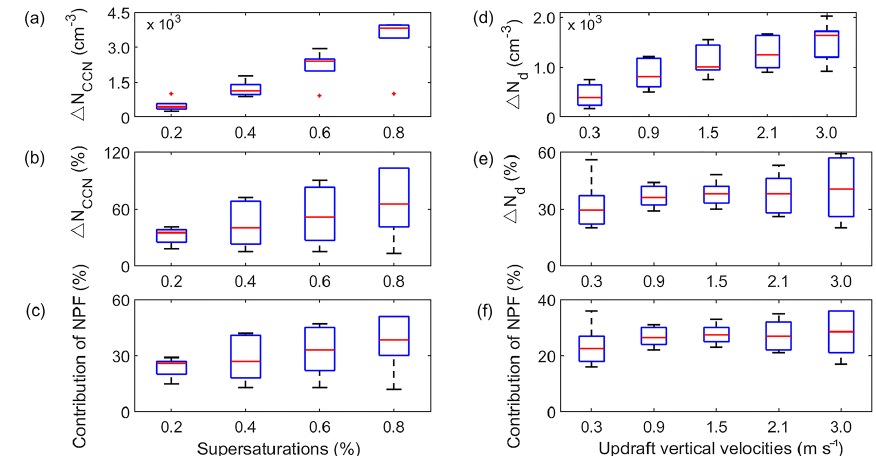
Figure 3. Box diagram of the increment of (a) CCN number concentration N CCN ( (cid:49)N CCN ), (b) enhanced percentage of N CCN and (c) the contribution to total N CCN by NPF for different supersaturations (0.2%–0.8%) and (d) cloud droplet number concentration N d ( (cid:49)N d ), (e) enhanced percentage of N d and (f) the contribution to total N d by NPF under different updraft velocities (0.3–3.0ms − 1